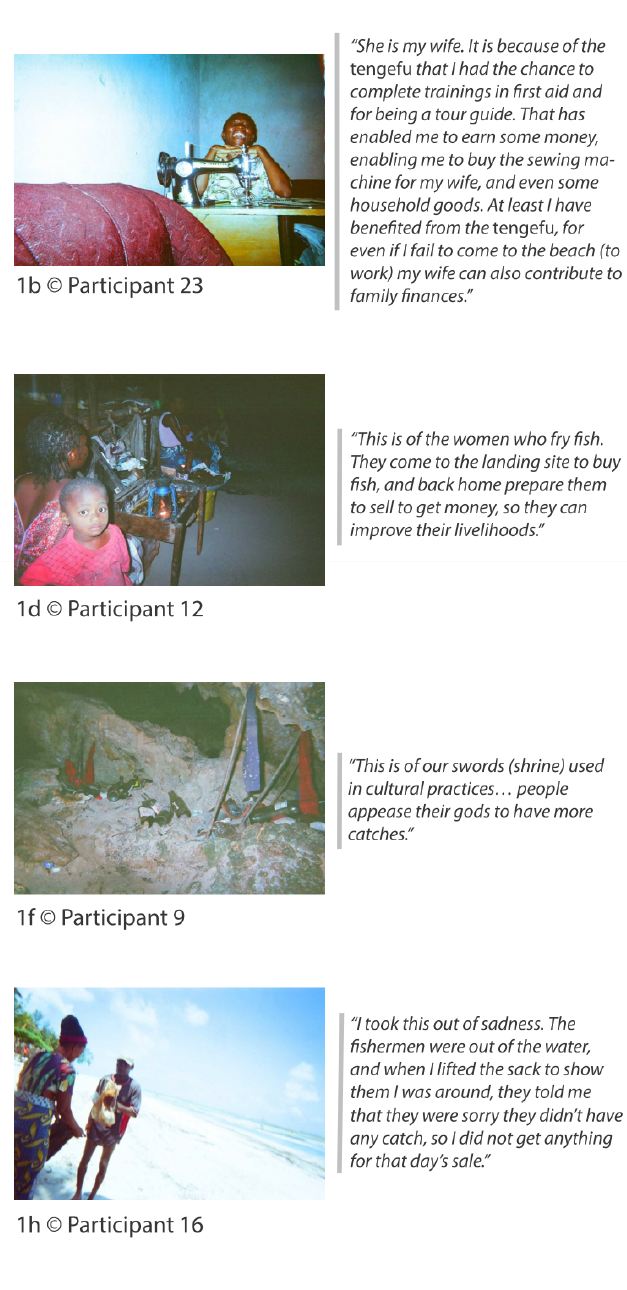
Fig. 1 . Kenya case study photographs and